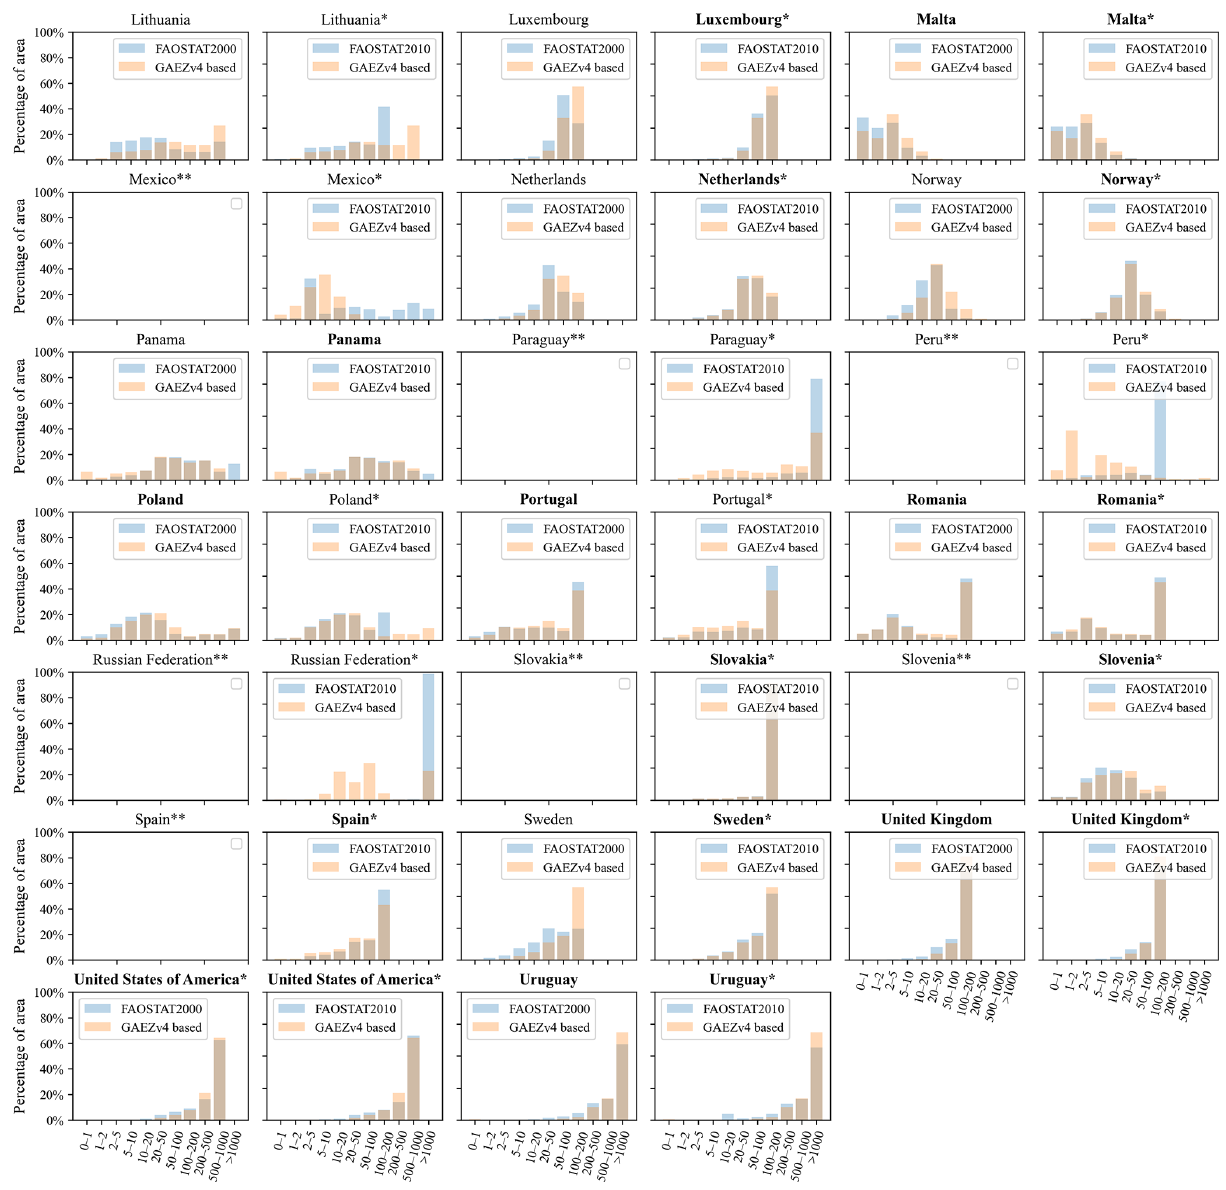
Figure 7. Comparison of the percentage of total crop area operated by each farm size (non-crop-specific farm size structure) between FAOSTAT structural data for the year 2000 and 2010 (FAO, 2022) and our farm-size-specific and crop-specific dataset based on the GAEZv4 crop map. Bold font country titles indicate that farm size structures in FAOSTAT are similar to our dataset. Note that for the year 2000, farm size structure from FAOSTAT structural data is the same as Lowder et al. (2016) except for one country (Fig. S5). Only the countries covered by our dataset and FAOSTAT are shown. The alternative version based on SPAM2010 crop map is given in Fig. A3. * FAOSTAT provides (part of) the structural data by interpolating other reported data, not directly from countries’ official reports. ** FAOSTAT provides no farm size structural data of the year 2000 or 2010 for